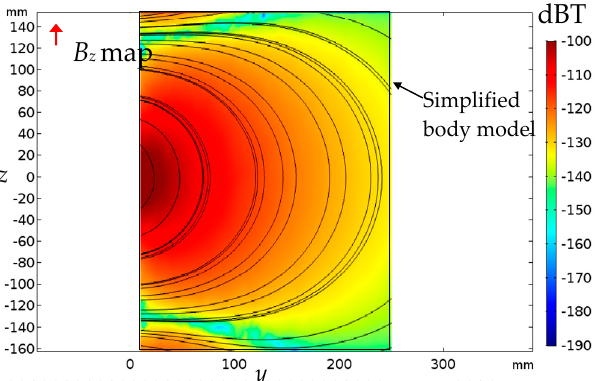
Figure 7. Strength lines and amplitude maps of B y (series excited, on the left) and B x (antiseries ex- cited, on the right) for different coil side length: l b = 50 mm ( a ), l b = 100 mm ( b ) and l b = 150 mm ( c ).